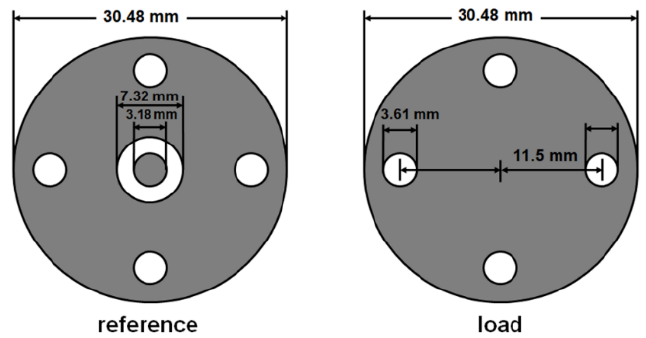
Figure 2. Fixture configuration for testing of electromagnetic interference (EMI) shielding effectiveness [29].